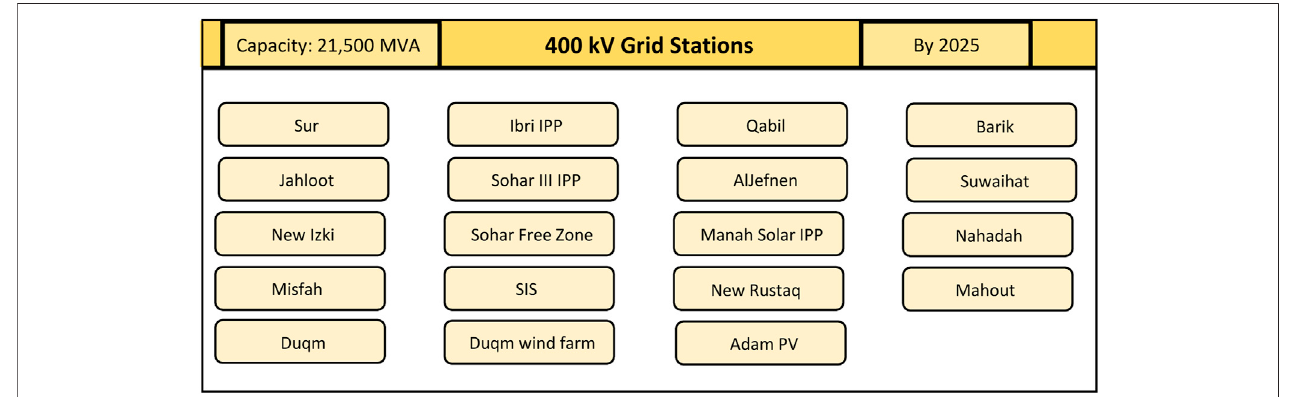
FIGURE 1 | Percentage of the allowable limits for different transmission voltage levels.